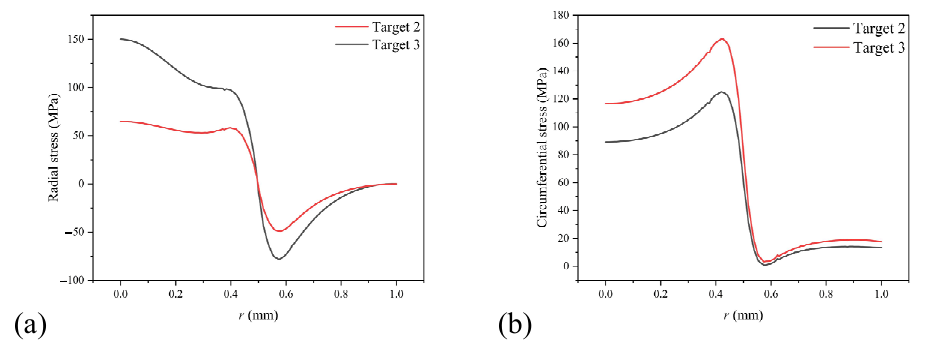
Figure 13. When the power density is 147.44 W/mm 2 , ( a ) the radial stress distribution of two targets and ( b ) the circumferential stress distribution of two targets.